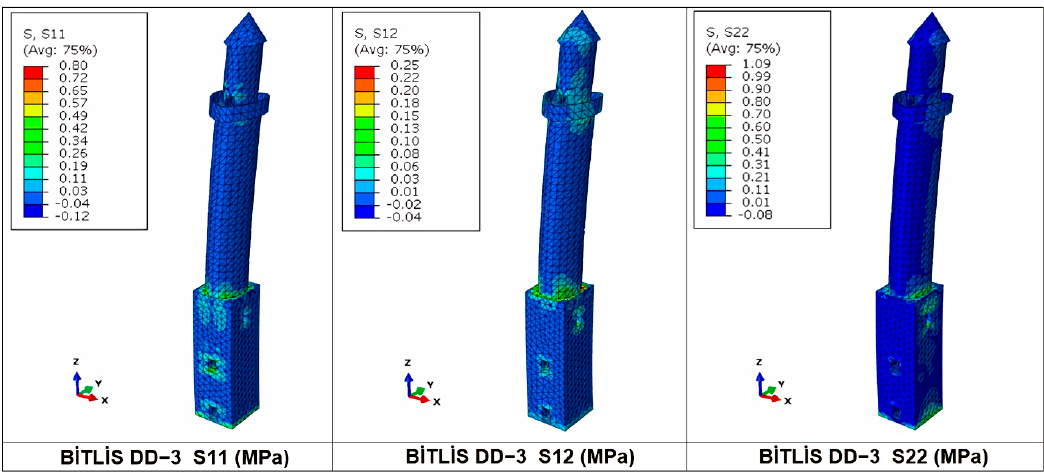
Figure 23. Stresses for DD − 2 ground motion level.